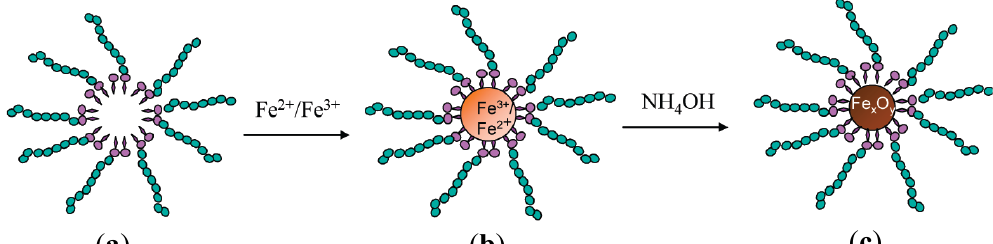
Figure 12. Strategy for the preparation of stabilized magnetic IONPs in aqueous media ( top ): - b -AEMA diblock copolymers in water; ( b ) addition of ( a ) micelle formation by PEGMA x y the Fe 3+ /Fe 2+ mixture to the micellar solution, leading to complexation of the iron salts by the β-ketoester units inside the micellar core; and ( c ) transformation of the iron salt “precursor” into IONPs inside the micellar core upon addition of NH OH solution; 4 atomic force microscopy (AFM) images of the block copolymer micelles loaded with IONPs ( bottom ): ( d ) height image; ( e ) amplitude image; and ( f ) phase image. Reprinted with permission from [36]. Copyright 2009 American Chemical